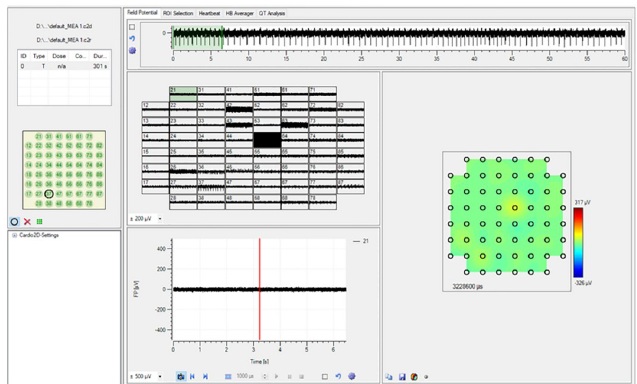
Fig 9. View of offline potential wave analysis software recorded in the channels of a 64-electrode plate.